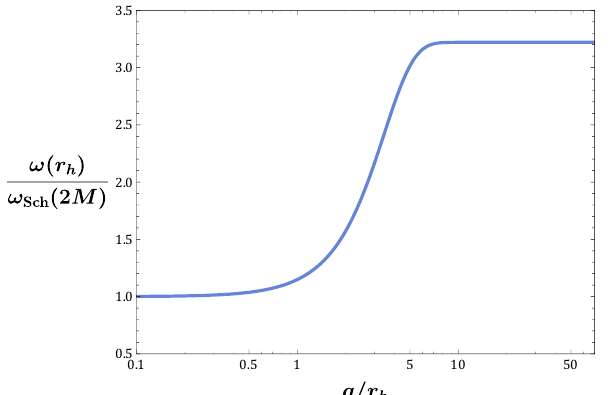
Figure 6. The graph of the ratio ω ( r h ) /ω Sch (2 M ) in terms of q/r h . Both quantities are dimen- sionless, while the horizontal axis is